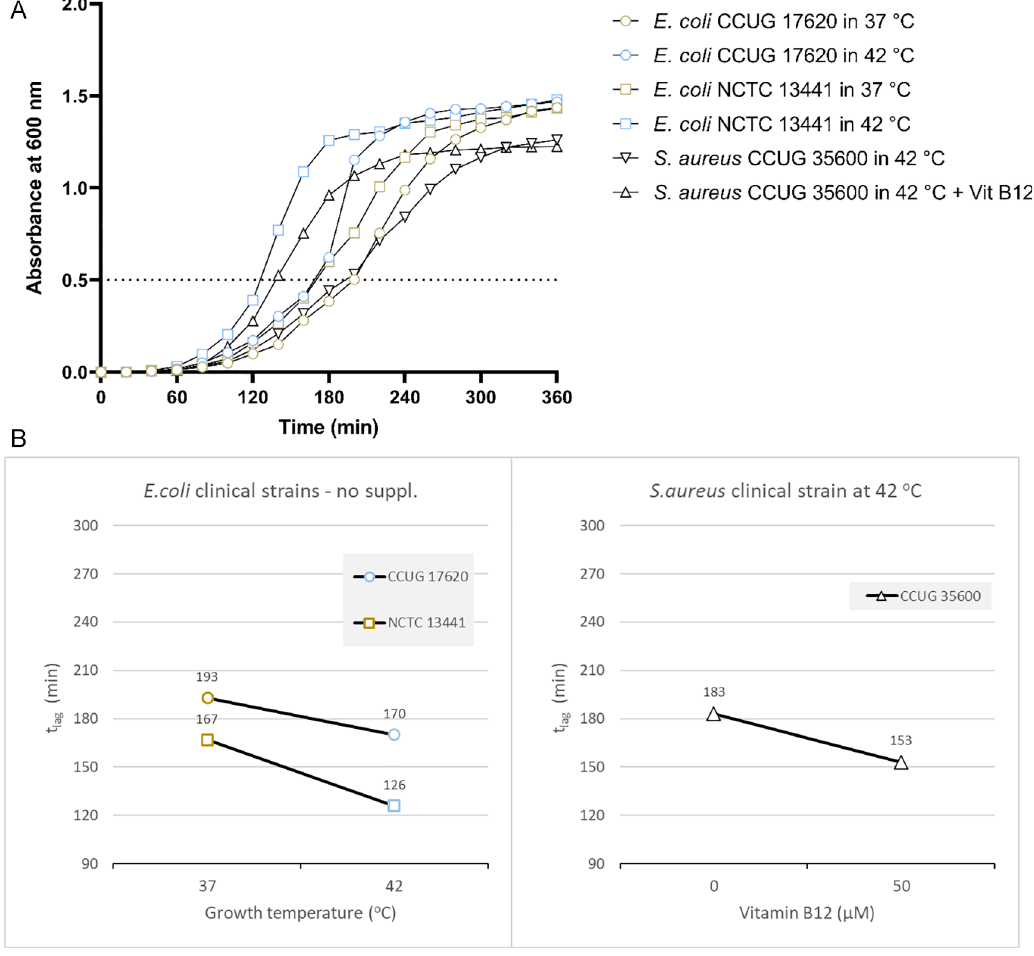
Figure 3. Results for the clinical strains E. coli CCUG17620 , E. coli NCTC13441, and S. aureus CCUG35600 under different growth conditions, including temperature, and vitamin B12 supplementation. (A) Growth curves of clinical bacterial isolates at 37 ° C and 42 ° C ( E. coli CCUG17620, E. coli NCTC13441), or with and without vitamin B12 supplement ( S. aureus CCUG35600 at 42 ° C). The dotted line indicates OD 0.5 for estimating the t lag from curves. (B) Effect plot of clinical samples in minutes (t lag ) to reach optical density